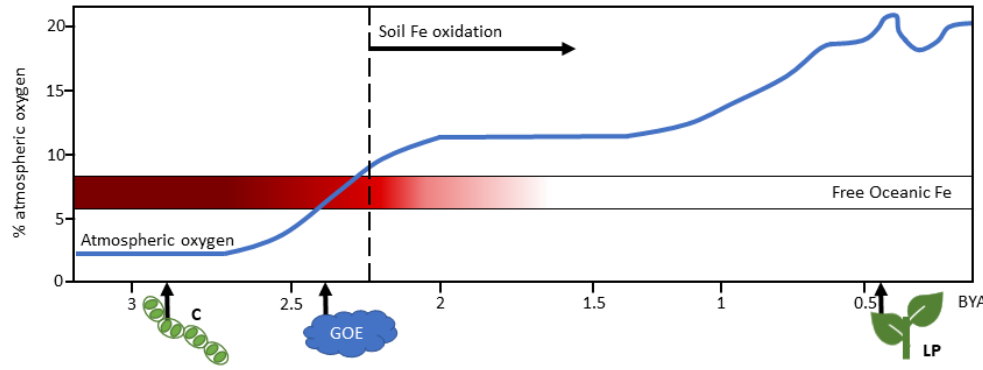
Figure 1. Conceptual model of relationship between atmospheric oxygen and Fe availability during Earth’s history. Percent atmospheric oxygen is presented on the y ‐ axis with time on the x axis. The early earth’s atmosphere contained about 0.001% oxygen until oxygenic photosynthesis began in Cyanobacteria about 2.7 billion years ago (BYA). The increase in oxygen formation led to lowered availability of Fe. Banding iron formations in strata are thought to represent times of intermittent Fe oxide formation from free oceanic Fe as atmospheric oxygen began to increase. Banding iron formations are not found prior to 3 BYA, suggesting the low oxygen content allowed for free Fe. Banding iron formation frequency peaks around 2.5 BYA and these are again not found following 1.8 BYA suggesting that Fe oxidation became constant. The start of soil Fe oxidation is dated to around 2.3 BYA. Timeline depicts billions of years ago. Blue line represents the general trend of increasing oxygen to current levels. Red gradient represents estimated amount of free Fe 2+ based on frequency of banding Fe patterns in strata with darker red representing more free Fe 2+ . Dotted line represents onset of soil Fe oxidation in the geological record. First occurrence of Cyanobacteria (C), the Great Oxygen Event (GOE) and land plants (LP) are noted along the x axis. Trends are based on data reviewed in [3,9].